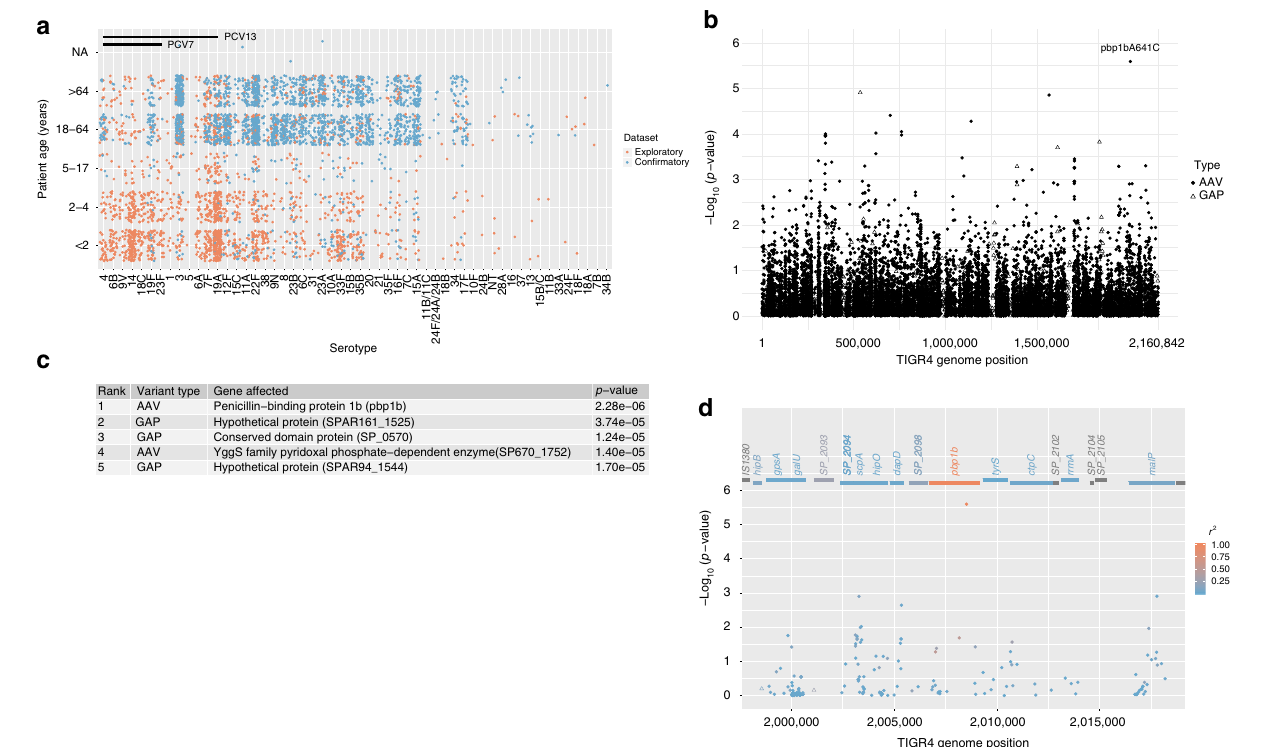
Fig. 2 Association between pneumococcal variants and meningitis in the con fi rmatory cohort. a Comparison of patient age and serotype distribution between the exploratory study isolates (orange) and the con fi rmatory study isolates (blue). PCV7 and PCV13 indicate serotypes included in the pneumococcal conjugate vaccine 7 and 13, respectively. b P -values ( − log 10 transformed) of test variants assessed by a linear mixed-effects model (LMM) controlling for population structure. Coding DNA sequence (CDS) variants were mapped to the corresponding position of the TIGR4 reference genome. Solid dots: non-synonymous CDS SNPs causing amino acid variations (AAVs). Open triangles: gene absence/presence variations (GAPs). c A list of top fi ve hits form the association study. d Regional plot of variant p-values near the pbp1b gene. AAVs (solid dots) and GAPs (open triangles) are colored according to their linkage disequilibrium (r 2 value) with the lead variant ( pbp1b